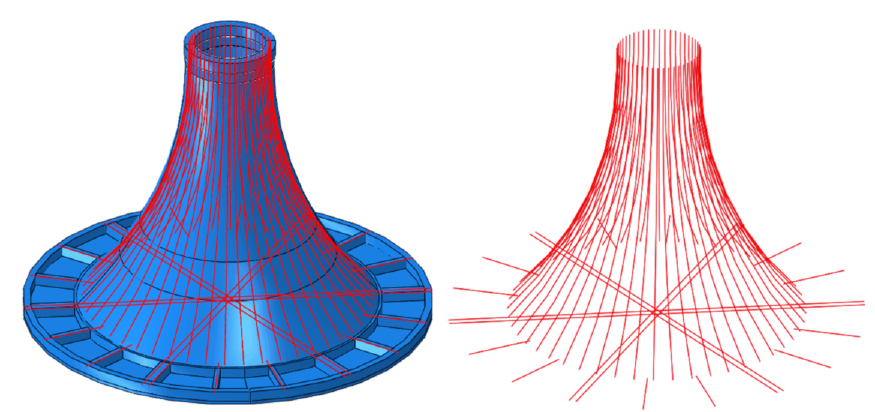
Figure 25. Prestressed system of